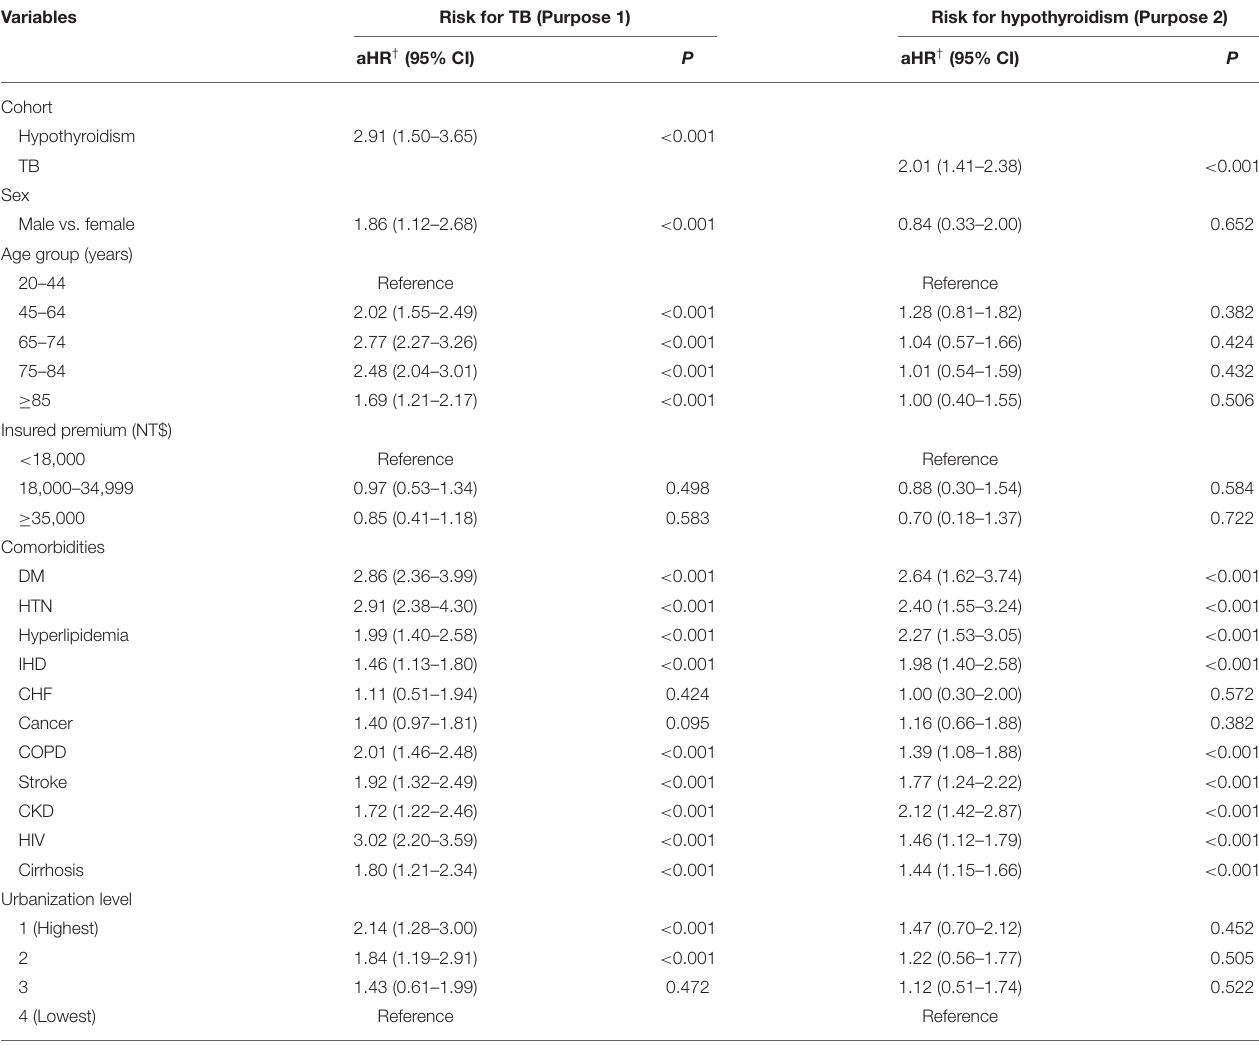
TABLE 2 | Factors related to events stratified by variables using Cox regression analysis.